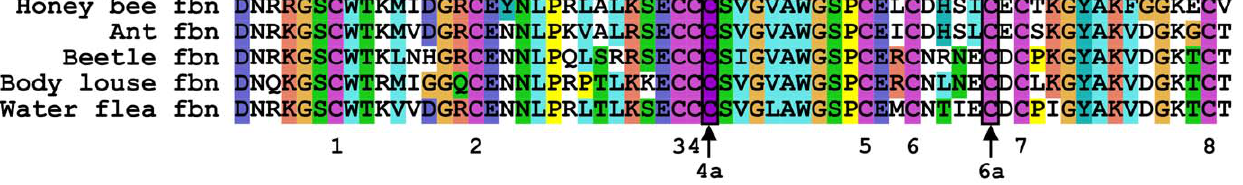
Figure 5. ClustalX alignment of the second hybrid domain in arthropods. Relative numbering of the cysteine residues in the hybrid 2 domain as identified in human fibrillins is indicated on the bottom. In arthropods, this domain has two additional cysteine residues (black boxes indicated by arrows) annotated here as cysteine 4a and 6a.